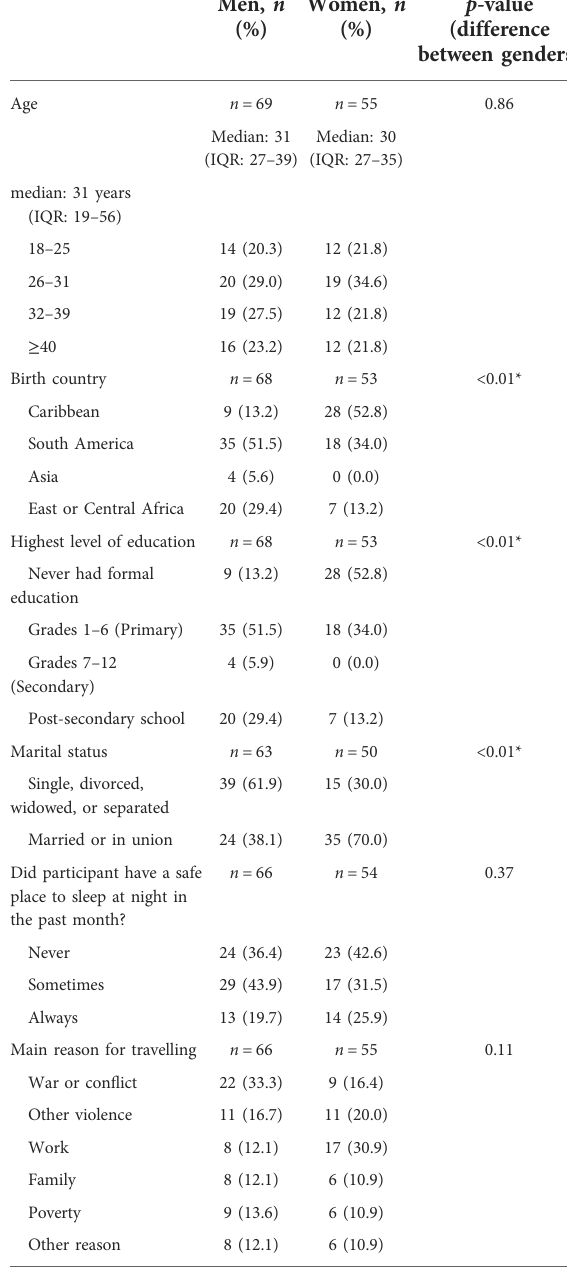
TABLE 1 Demographic characteristics (self-reported by adults age ≥ 18 years). Men,